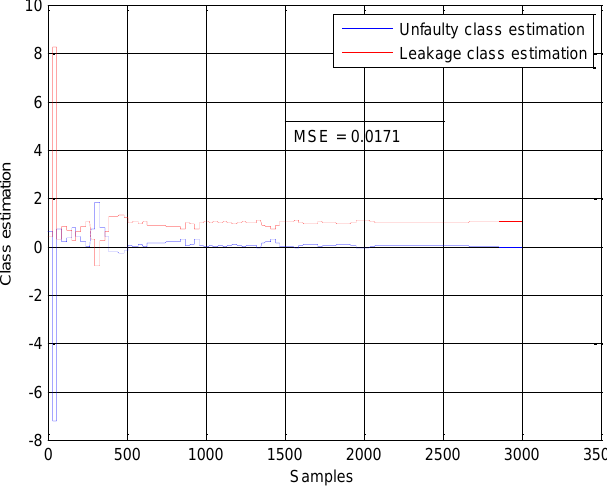
Figure 7. Engine_speed = 1000 rpm and torque = 150